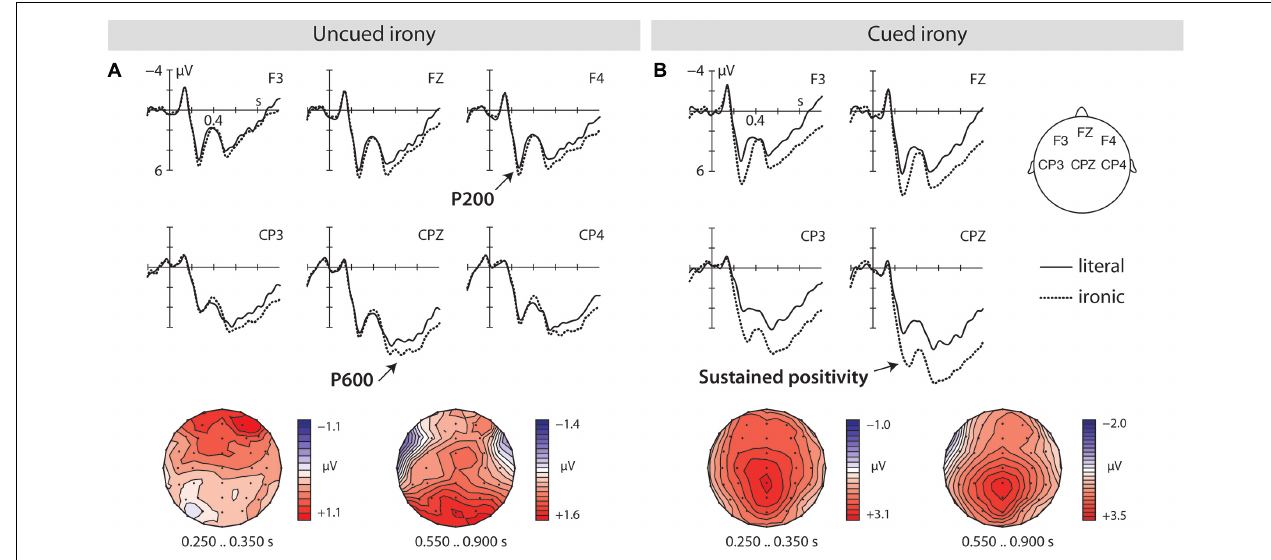
FIGURE 3 | Grand average ERPs to literal (solid line) and ironic (dotted line) sentence final words shown for uncued irony (A) and cued irony (B) presented in two separate experimental blocks. Topographic maps of the ERP effects are displayed in the lower part of each